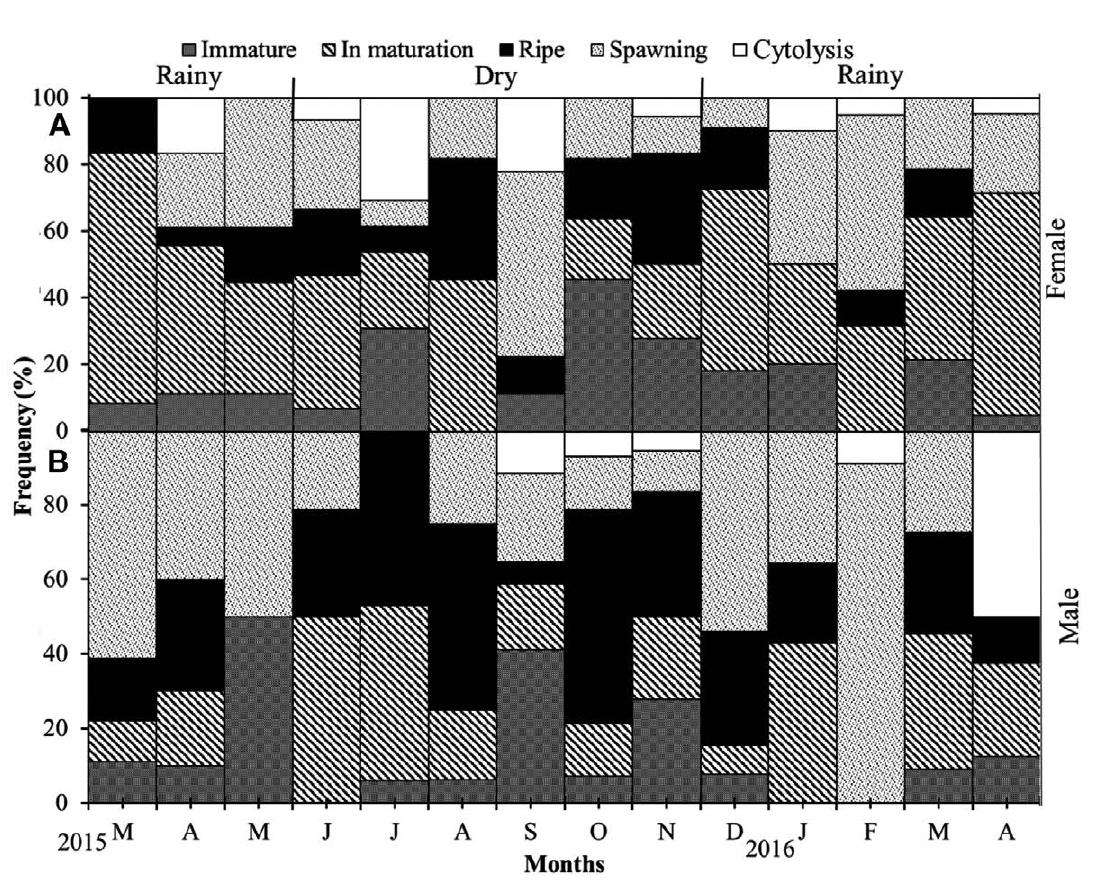
Fig. 5. – Frequency of maturation stages in females (A) and males (B) of Donax striatus during the study period